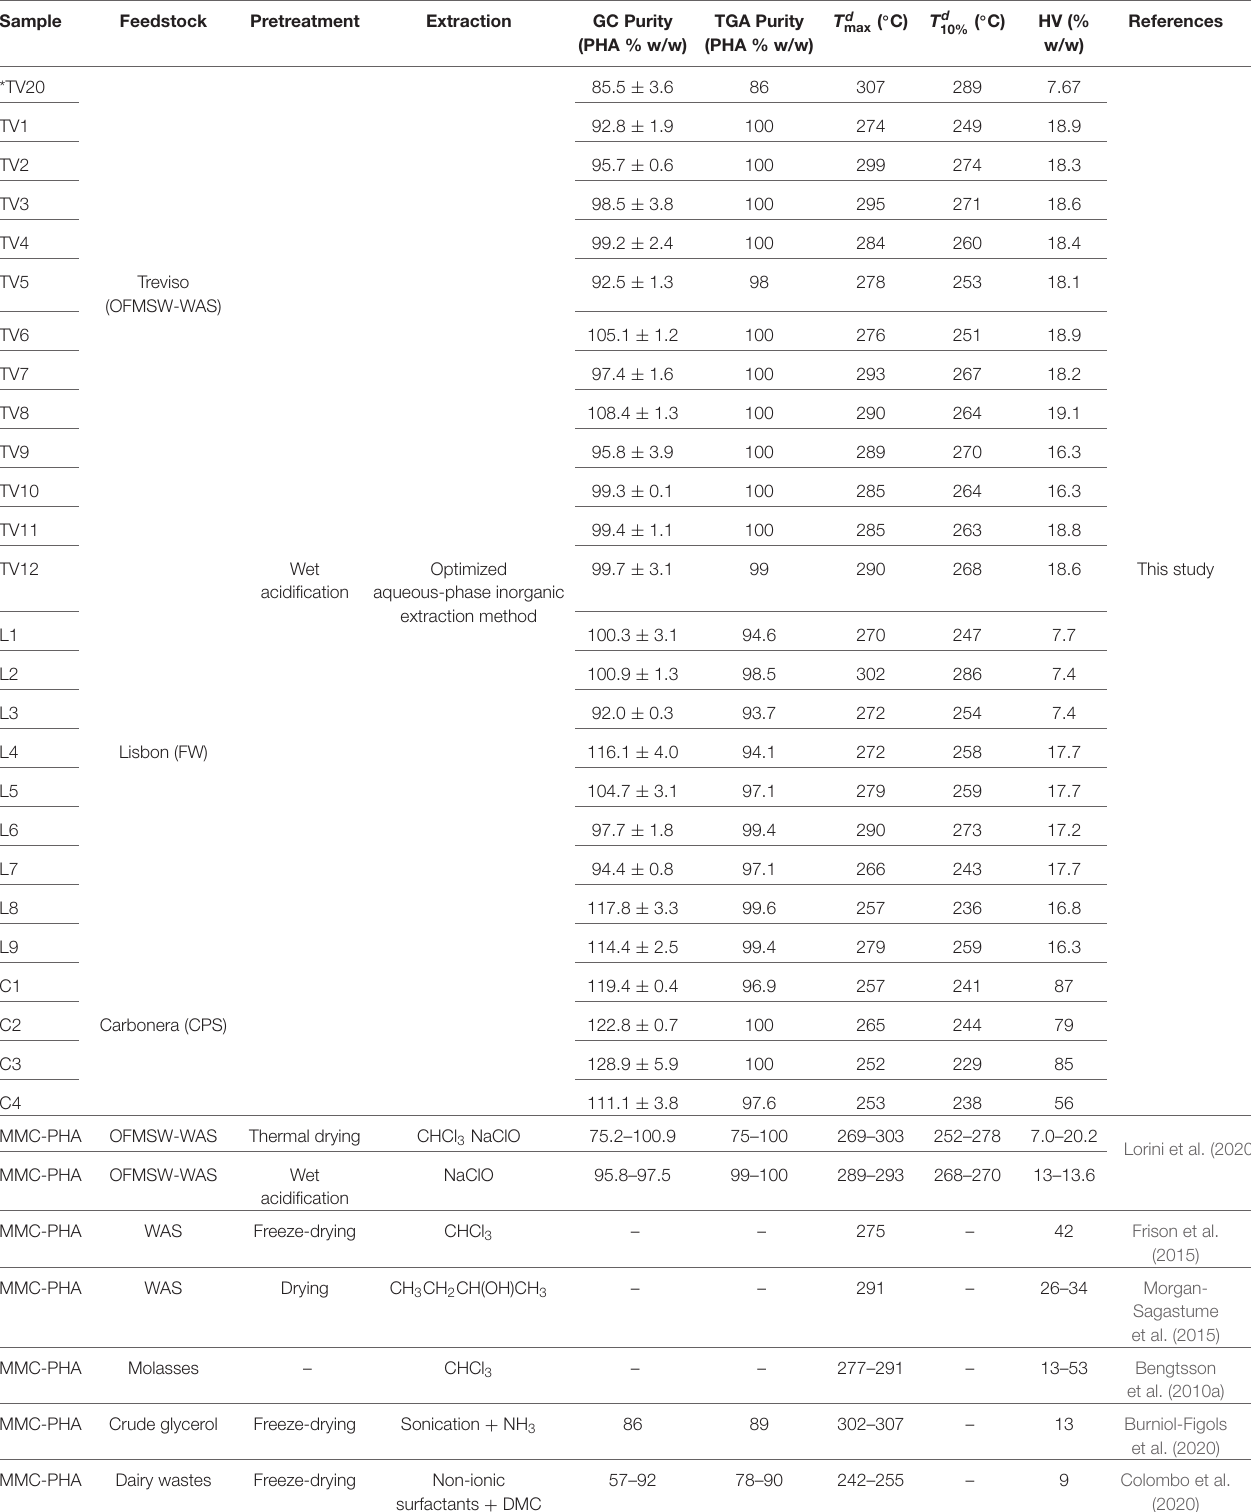
TABLE 1 | Chemical and thermal properties of PHA samples produced in Treviso, Lisbon, and Carbonera pilot plants. Sample